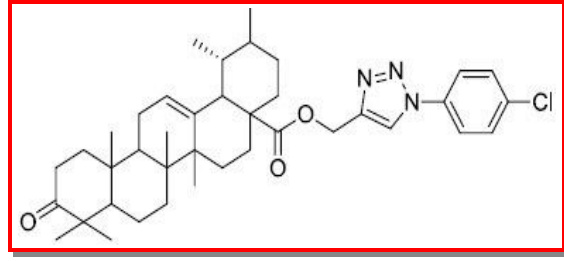
Figure 1: Structure of ursolic acid chlorophenyltriazole